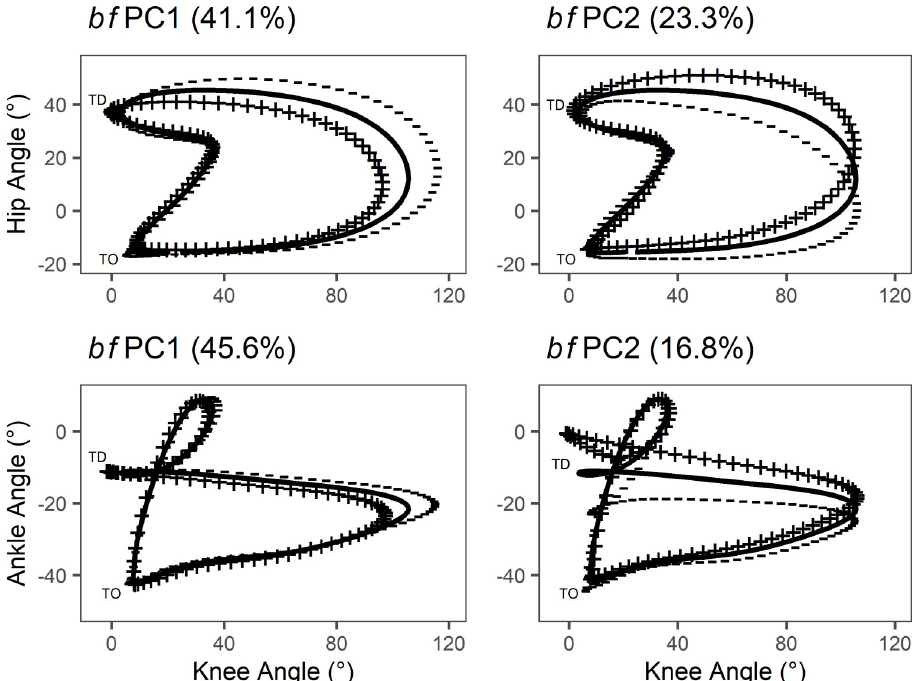
Fig 5. bf PCA of hip-knee and knee-ankle joint couples throughout stride cycle. First two bfPCs from hip-knee and knee-ankle bf PCA with the percentage of group variability explained. Solid line represents the mean angle-angle curve. ‘+’ line represents positive scorers +2SD from the mean function. ‘-’ line represents negative scorers -2SD from the mean function.